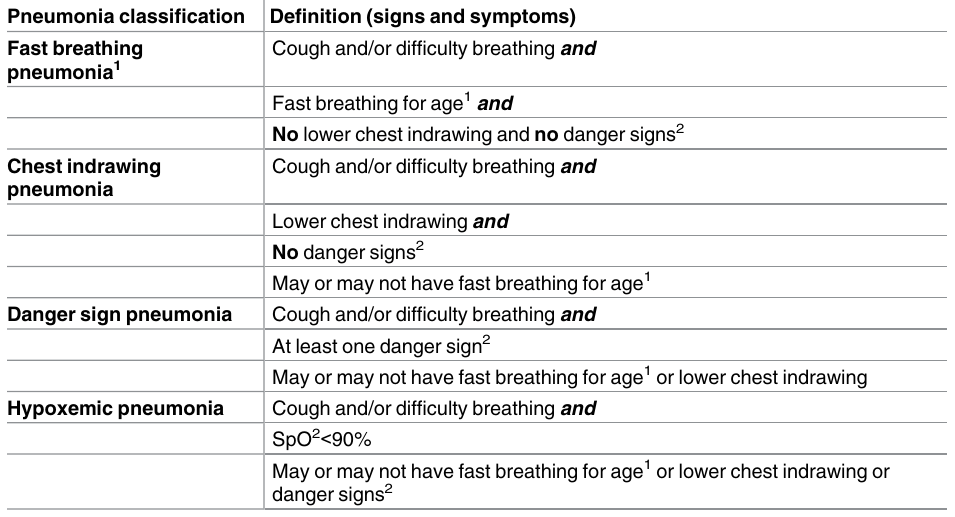
Table 1. Clinical and hypoxemic pneumonia definitions Pneumonia classification Definition (signs and